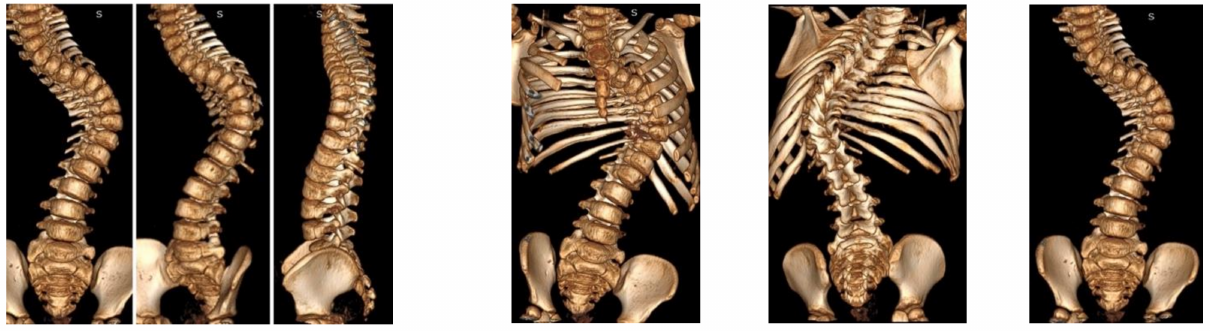
Figure 2. CT-3D preoperative